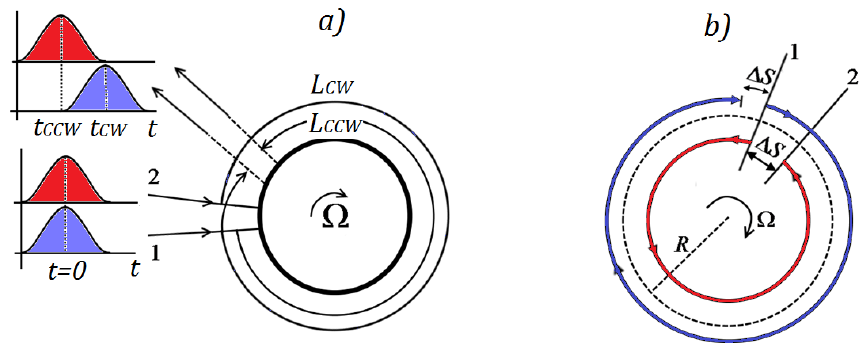
Figure 5. In a disk rotating with a clockwise (CW) angular velocity: ( a ) different rotation induced optical paths of the clockwise and counter-clockwise (CCW) optical beams, L CW and L CCW , respectively; and ( b ) identical difference, Δ S , between the rotation induced optical paths of the clockwise and counter-clockwise optical beam, and the standing optical path.